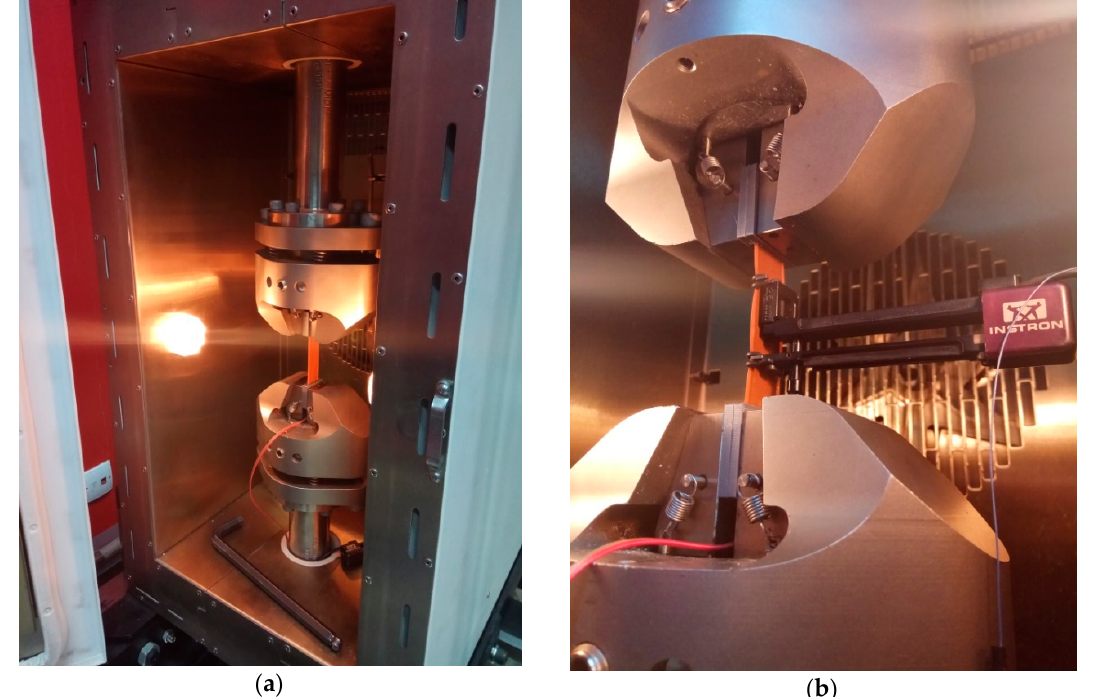
Figure 2. The sample fastened in the jaws ( a ) and an extensometer installed on the tested sample ( b ).